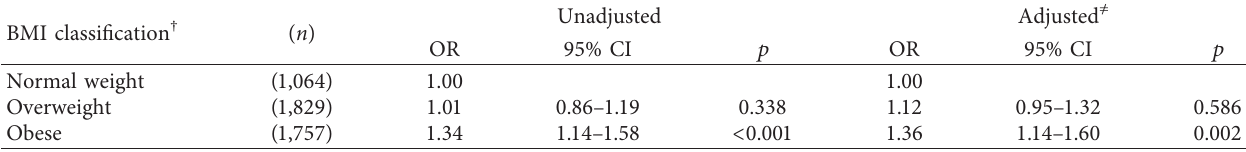
Table 3: The association between obesity and multisite pain in the lower limbs, n � 4,650 ∗ . BMI classification